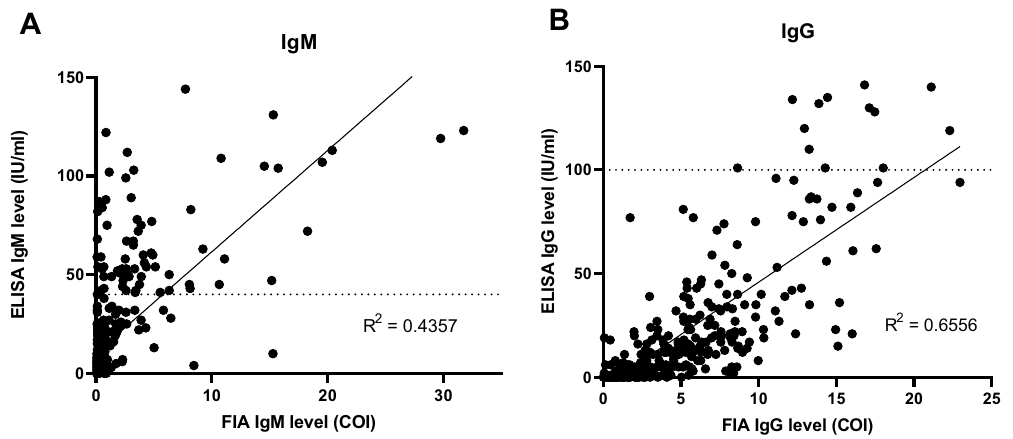
Figure 2. ( A ) IgM and ( B ) IgG levels from the FIA (COI) and ELISA (IU/ml) were plotted. The dot lines represented IgM and IgG ELISA cut-off values at 40 and 100 IU/ml. The cut-off index (COI) ratio between test and control bands on each FIA is referred to signal strength 11 . The coefficient of determination (R 2 ) was shown, created by GraphPad